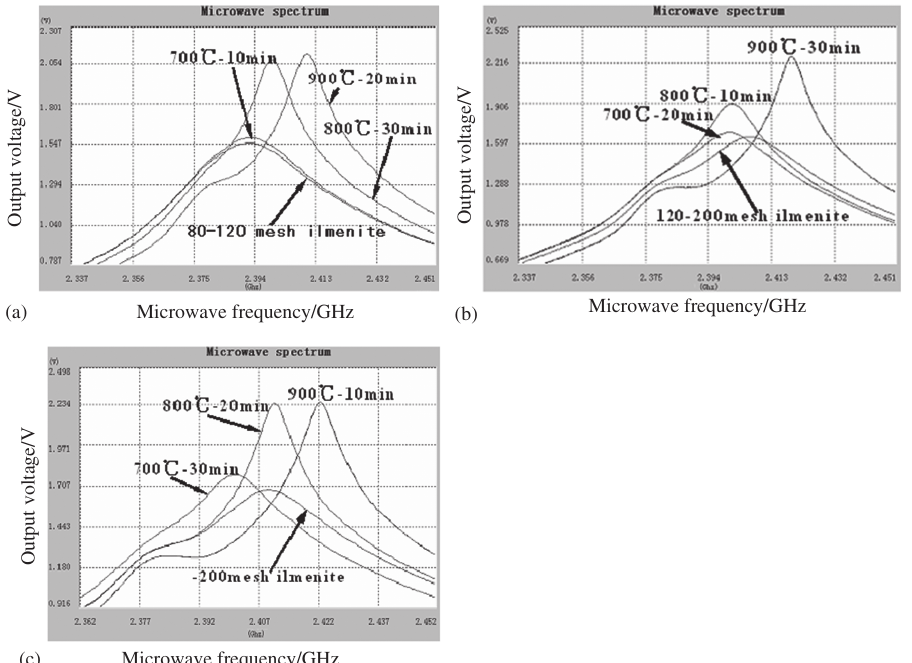
Figure 2: The microwave spectra of oxidation products oxidised at different temperatures for varying times from the ilmenite concentrates of different sizes: (a) particle size: – 80 + 120 mesh; (b) particle size: – 120 + 200 mesh; (c) particle size: – 200 mesh. The lines not labeled with time are the spectra for raw samples.